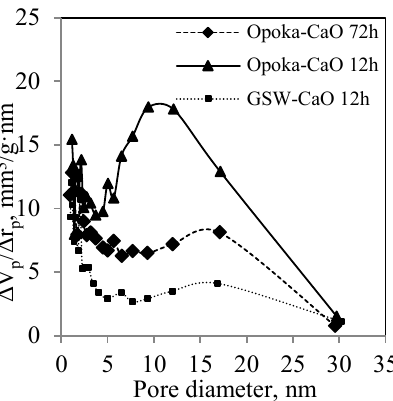
Figure 11. Differential distribution of the pore sizes in the products (CaO/SiO 2 = 1.0 at 200 ◦ C) after 12 h and 72 h of